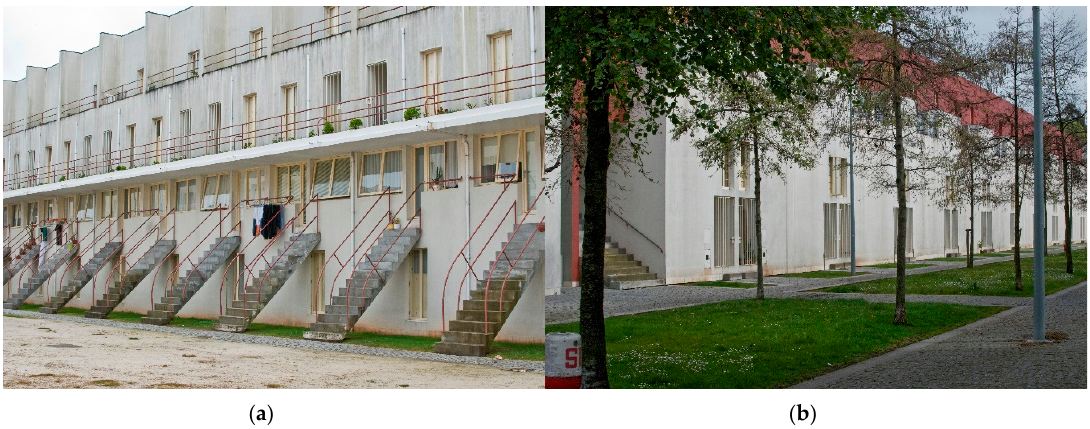
Figure 8. SAAL Estate of Bouça, Porto, Portugal, by Architect Alvaro Siza, 1st Phase 1973–78, 2nd Phase 1999–2006: ( a ) Gallery access; ( b ) Direct access.